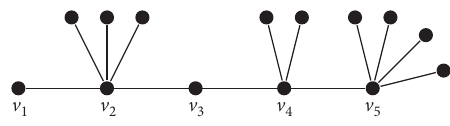
Figure 2: The caterpillar P